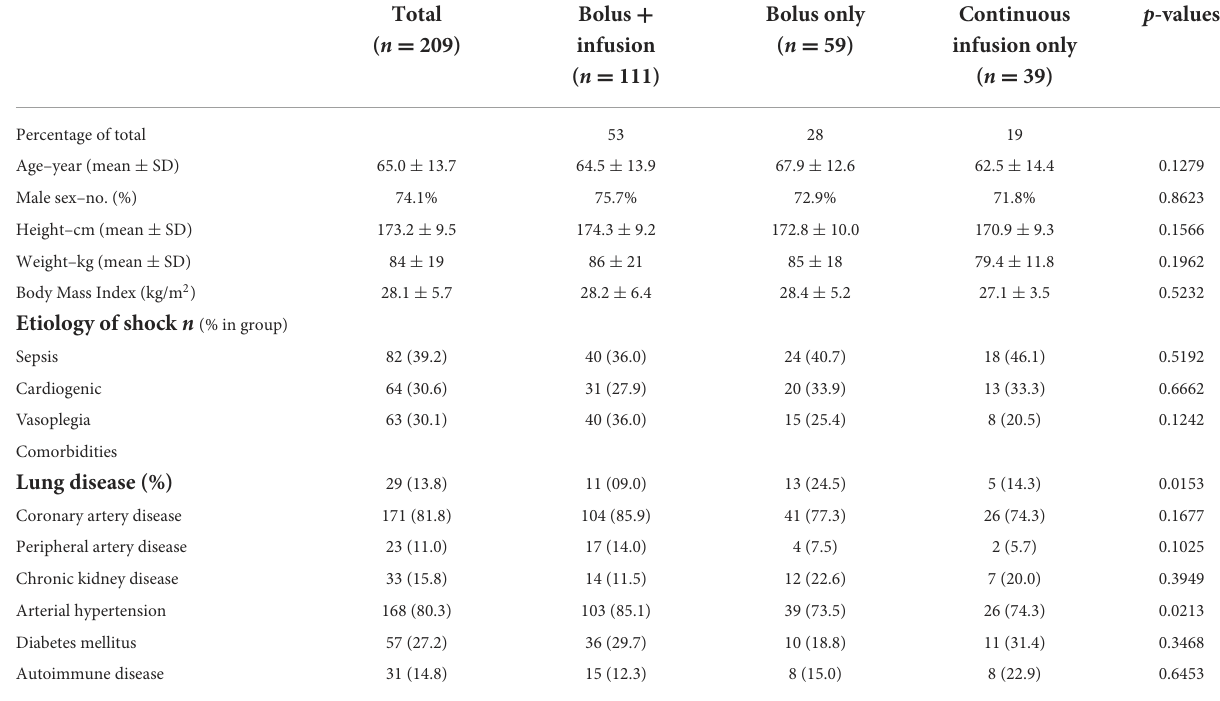
TABLE 1 Demographic data and comorbidities in shock